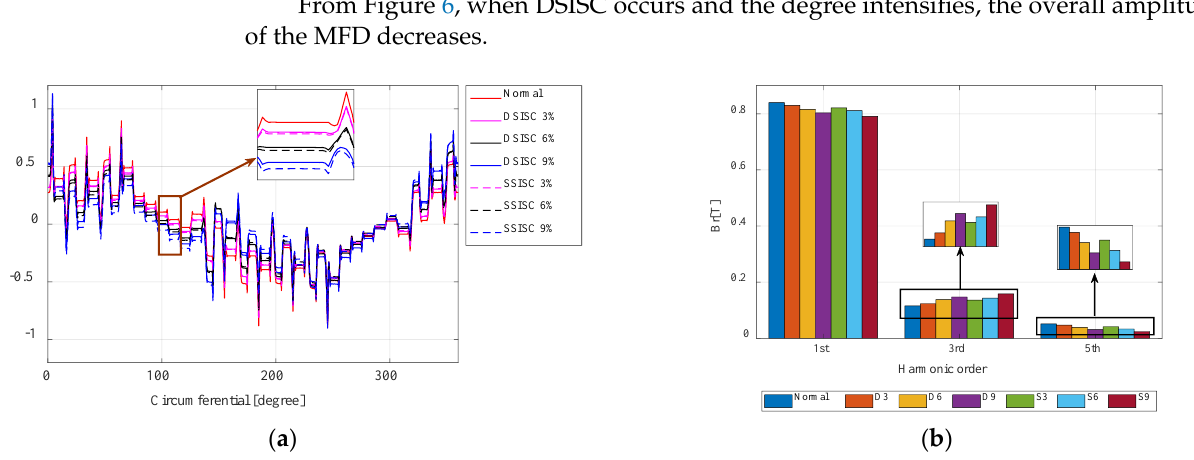
Figure 6. MFD variations: ( a ) and ( b ) varied dynamic short circuit degrees.